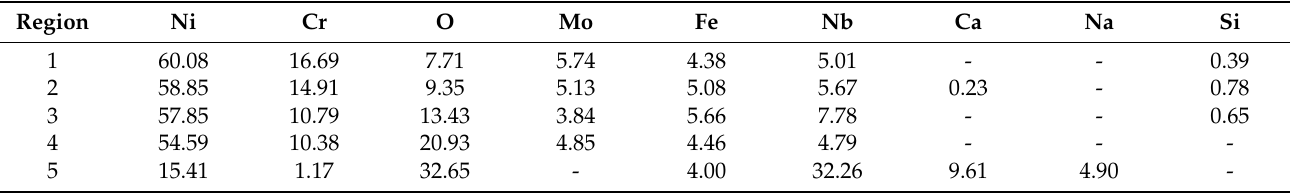
Table 6. EDS elemental analysis of regions marked in Figure 8 for IN625 alloy (in